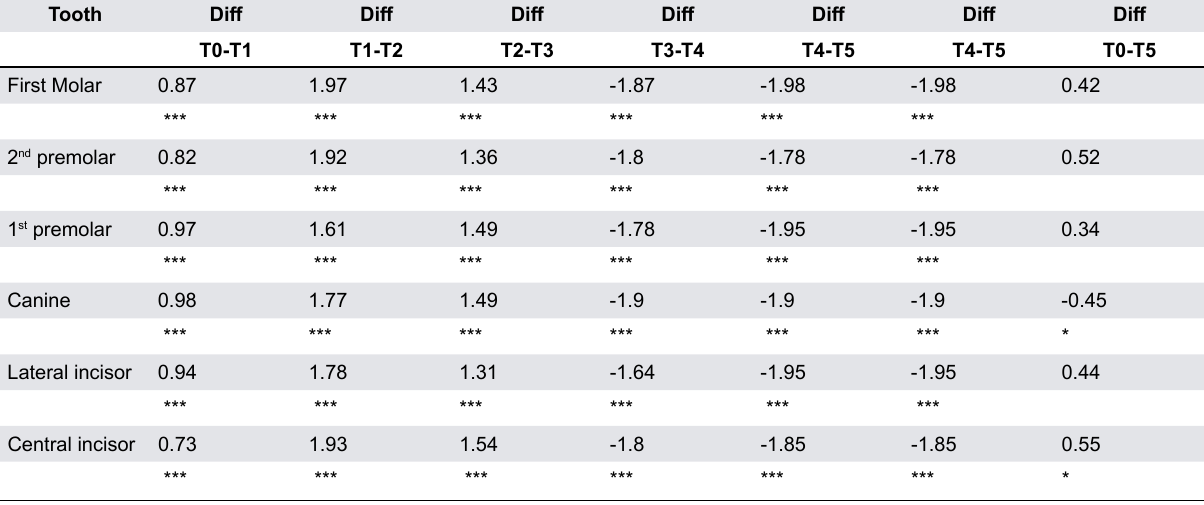
Table 3- Diff. between means and p-values for the PBF from baseline (T0) to (T5) for each measured tooth in 0.016-inch NiTi archwire